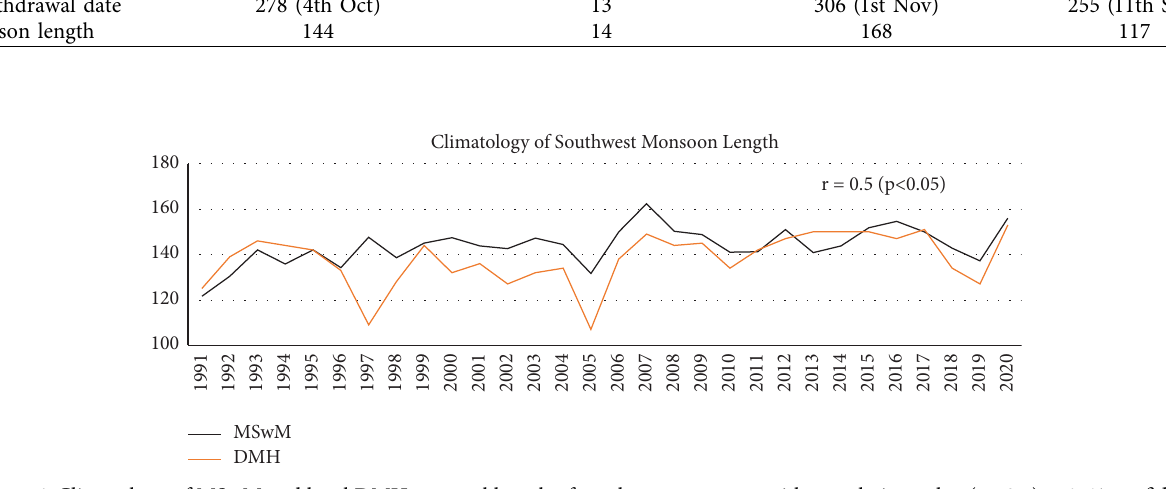
Figure 6: Climatology of MSwM and local DMH seasonal length of southwest monsoon with correlation value ( r � 0.5) at 95% confdence level ( p < 0 . 05).